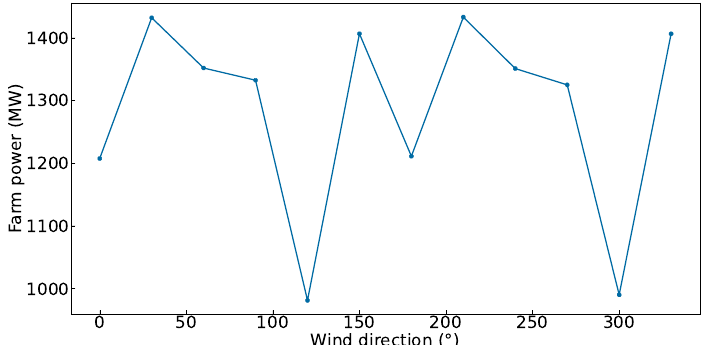
Figure 6. Variation of farm power with wind direction (for a fixed inflow speed of 11.4